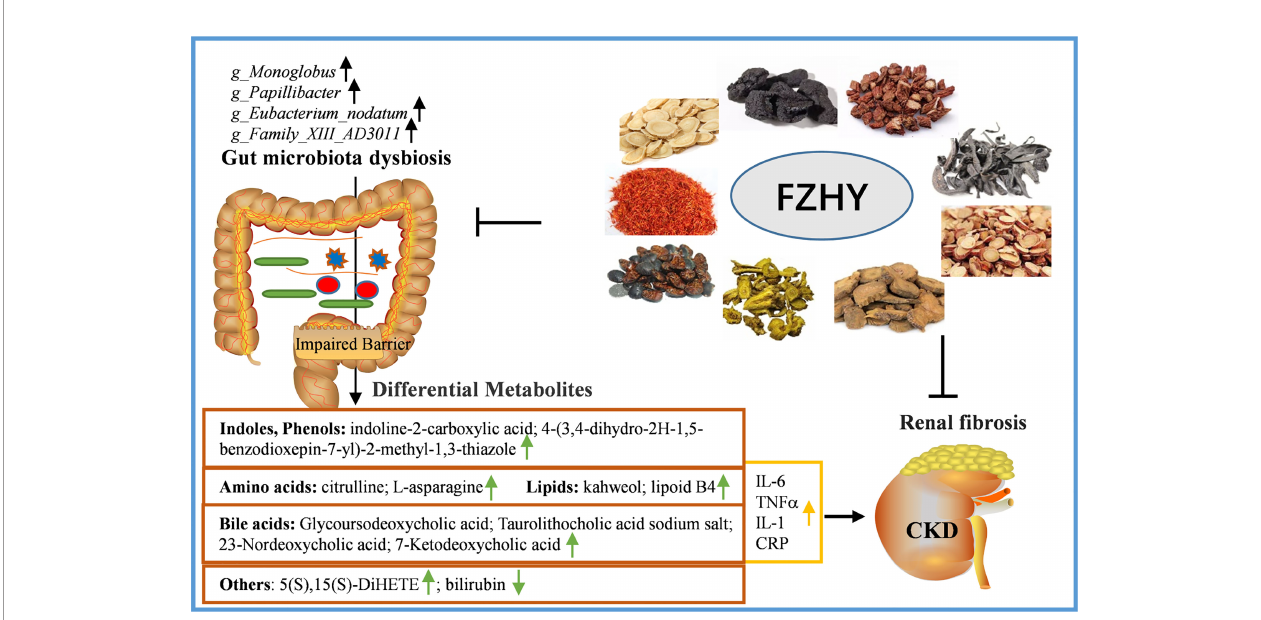
FIGURE 9 | A schematic diagram of the mechanisms of FZHY protecting the pathogenesis of CKD by regulating intestinal fl ora and its related